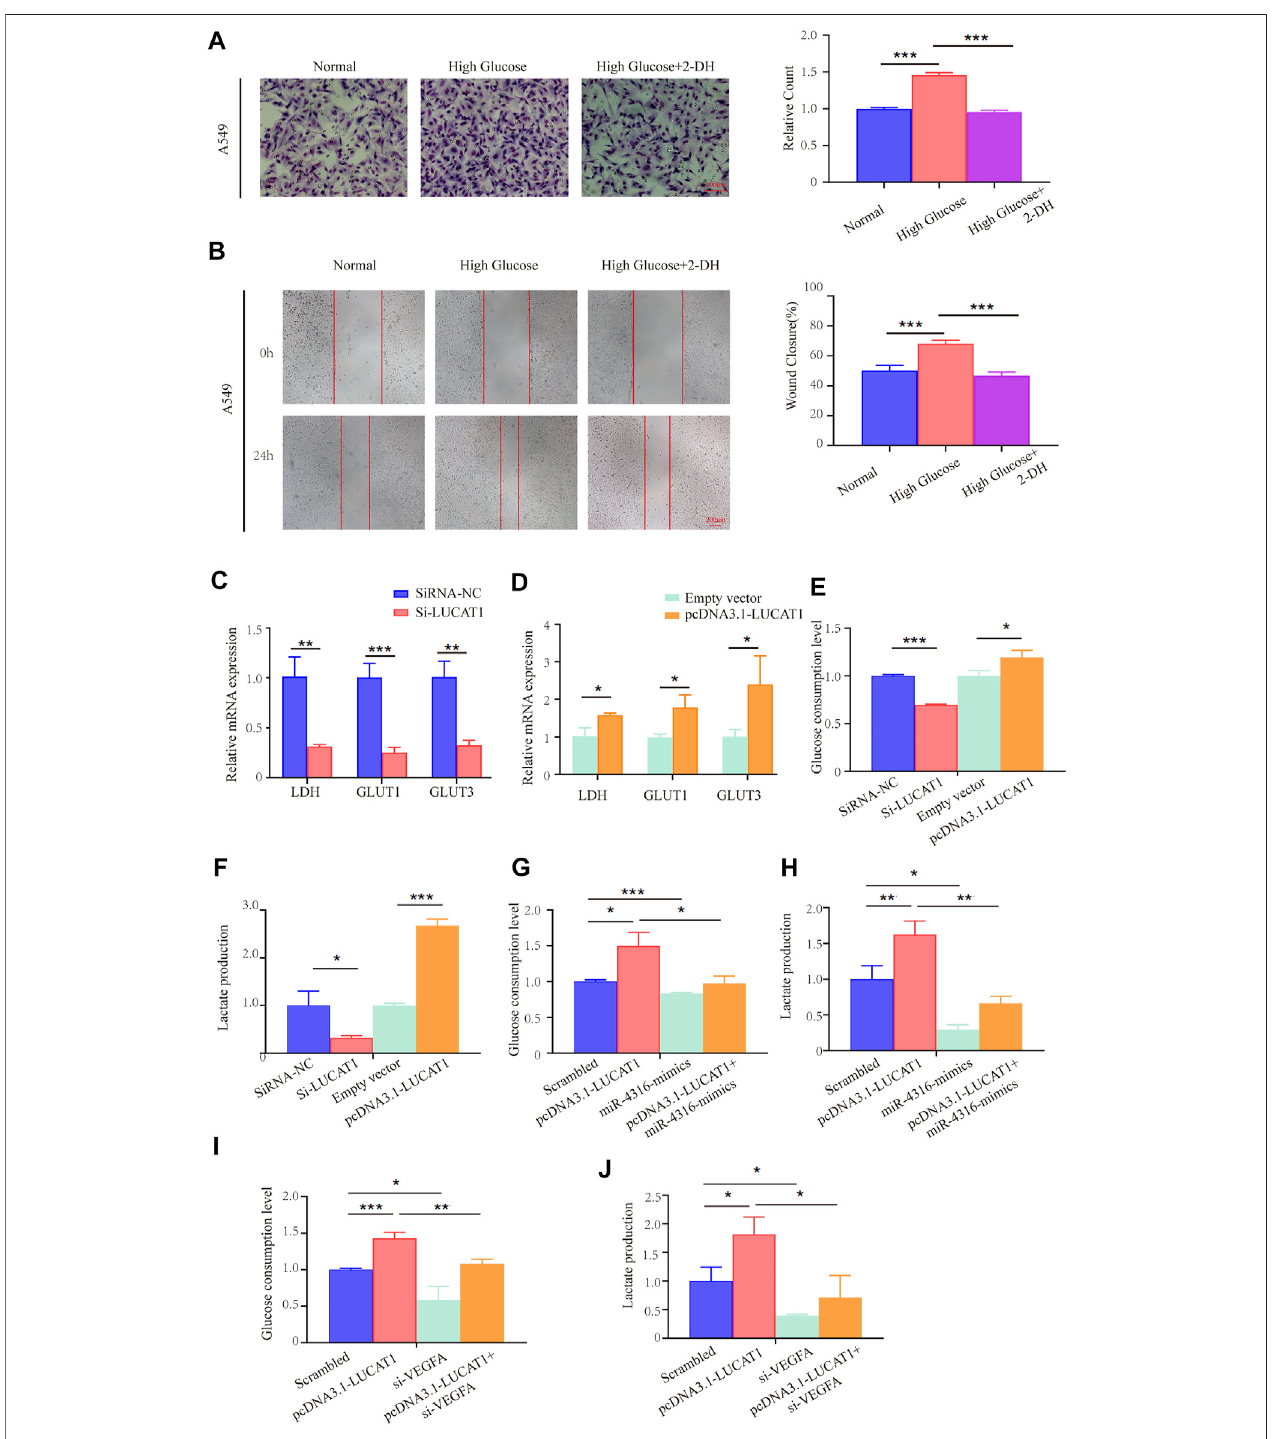
FIGURE 7 | LUCAT1 promotes glycolysis in LUAD cells through the LUCAT1/miR-4316/VEGFA axis. (A,B) Migration and invasion ability of LUAD cells were analyzed under normal culture conditions with high concentration of glucose; glycolysis inhibitor 2-DG abolished the ability of the migration and invasion ability of LUAD cells. (C,D) qRT-PCR was performed to detect the expression of Glycolysis-related enzyme markers in A549 cells after transfected with si-LUCAT1, pcDNA3.1- LUCAT1orcorrespondingnegativecontrol. (E,F) Lactateproductionandglucoseconsumptionlevelweremeasuredaftertransfectedwithsi-LUCAT1,pcDNA3.1- LUCAT1orcorrespondingnegativecontrol. (G,H) Lactateproductionandglucoseconsumptionlevelweremeasuredafterco-transfectionwithnegativecontrolmimics, miR-4316 mimics, or/and overexpression plasmid (pcDNA3.1- LUCAT1), using reagent kit according to the instruction of the manufacturers, respectively. (I,J) Lactate production and glucose consumption level were measured after co-transfection with negative control siRNA, si-LUCAT1, or/and overexpression plasmid (pcDNA3.1- LUCAT1), using reagent kit according to the instruction of the manufacturers, respectively. p -values were calculated by two-tailed student ’ s t-test or one-way ANOVA (* p < 0.05; ** p < 0.01; *** p < 0.001).